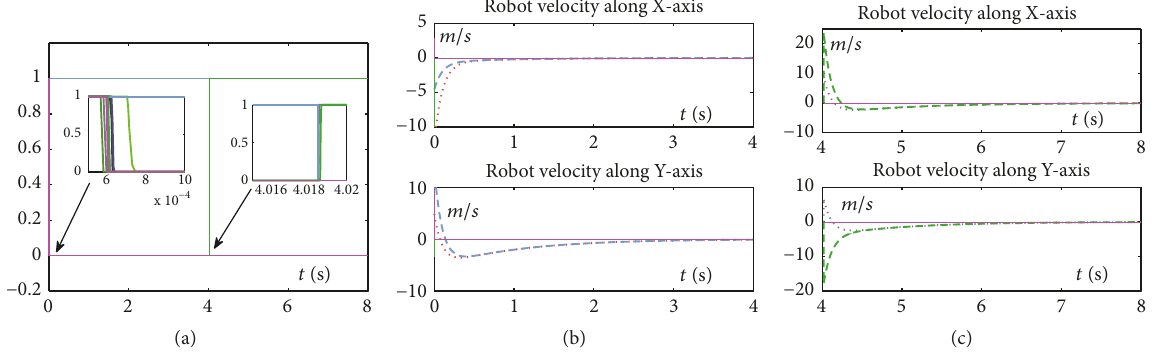
Figure 6: Outputs of 𝑘 -WTAnetwork in centralized model (12) with 𝑘 = 2 as well as the corresponding velocities of mobile robots at different phases. (a) Outputs of 𝑘 -WTA network with 𝑘 = 2 . (b) Velocities of mobile robots of phase 1. (c) Velocities of mobile robots of phase 2.